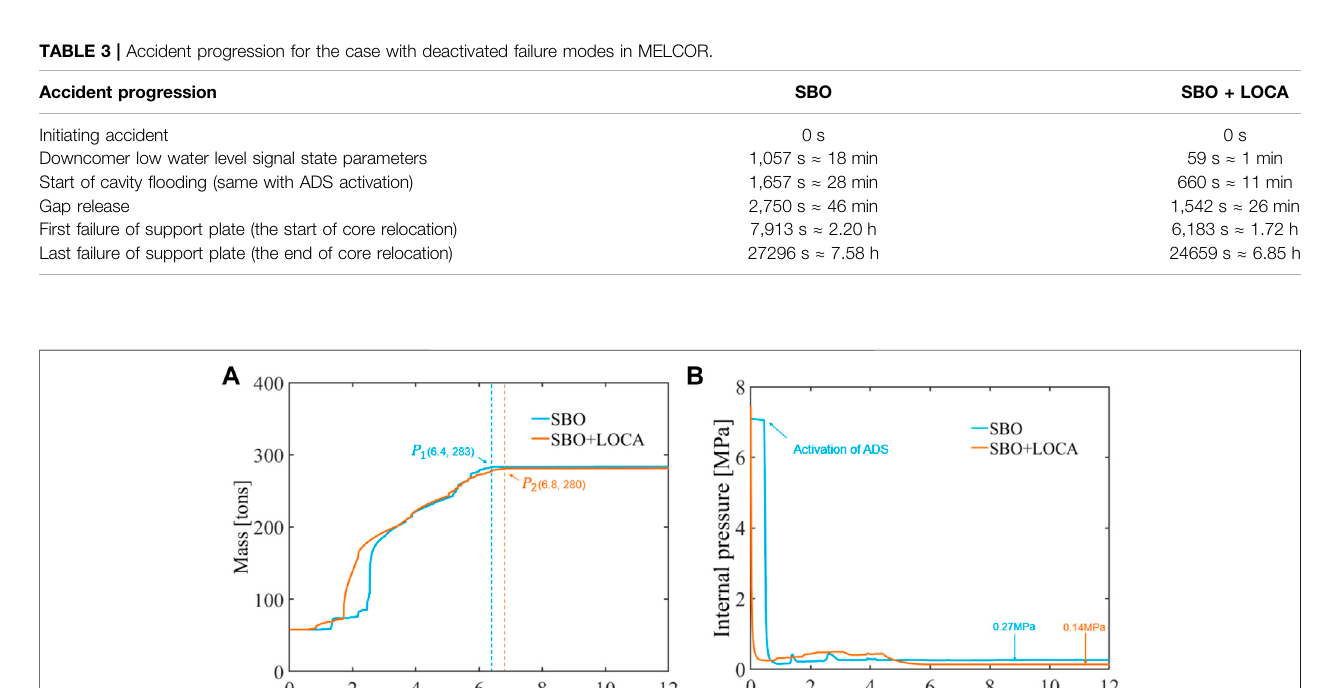
Frontiers in Energy Research |